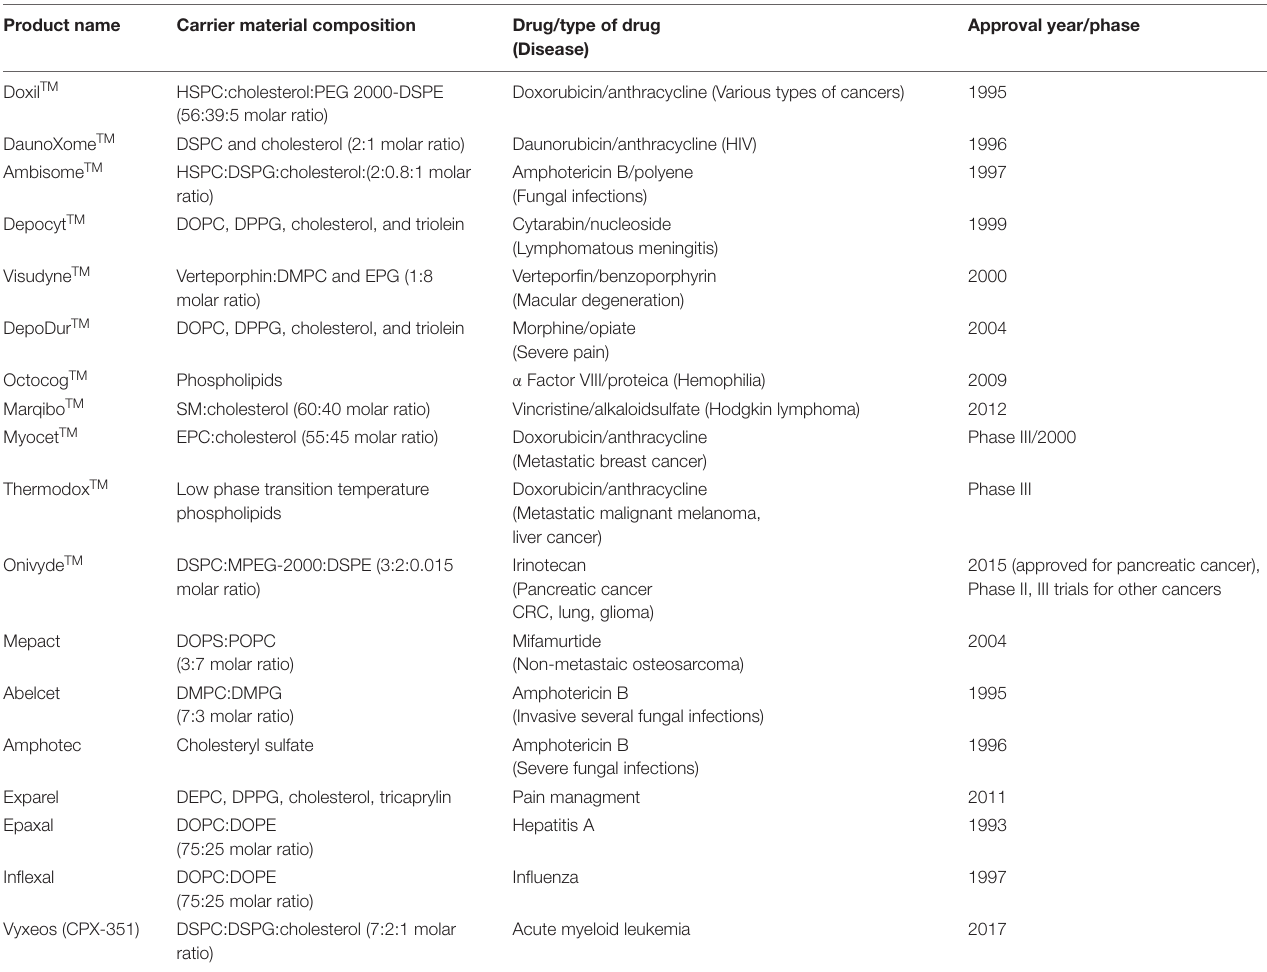
TABLE 2 | List of nanoengineered liposomal therapeutic delivery systems either approved by FDA or in advanced clinical trials (Felice et al., 2014; Bulbake et al., 2017; Patra et al.,